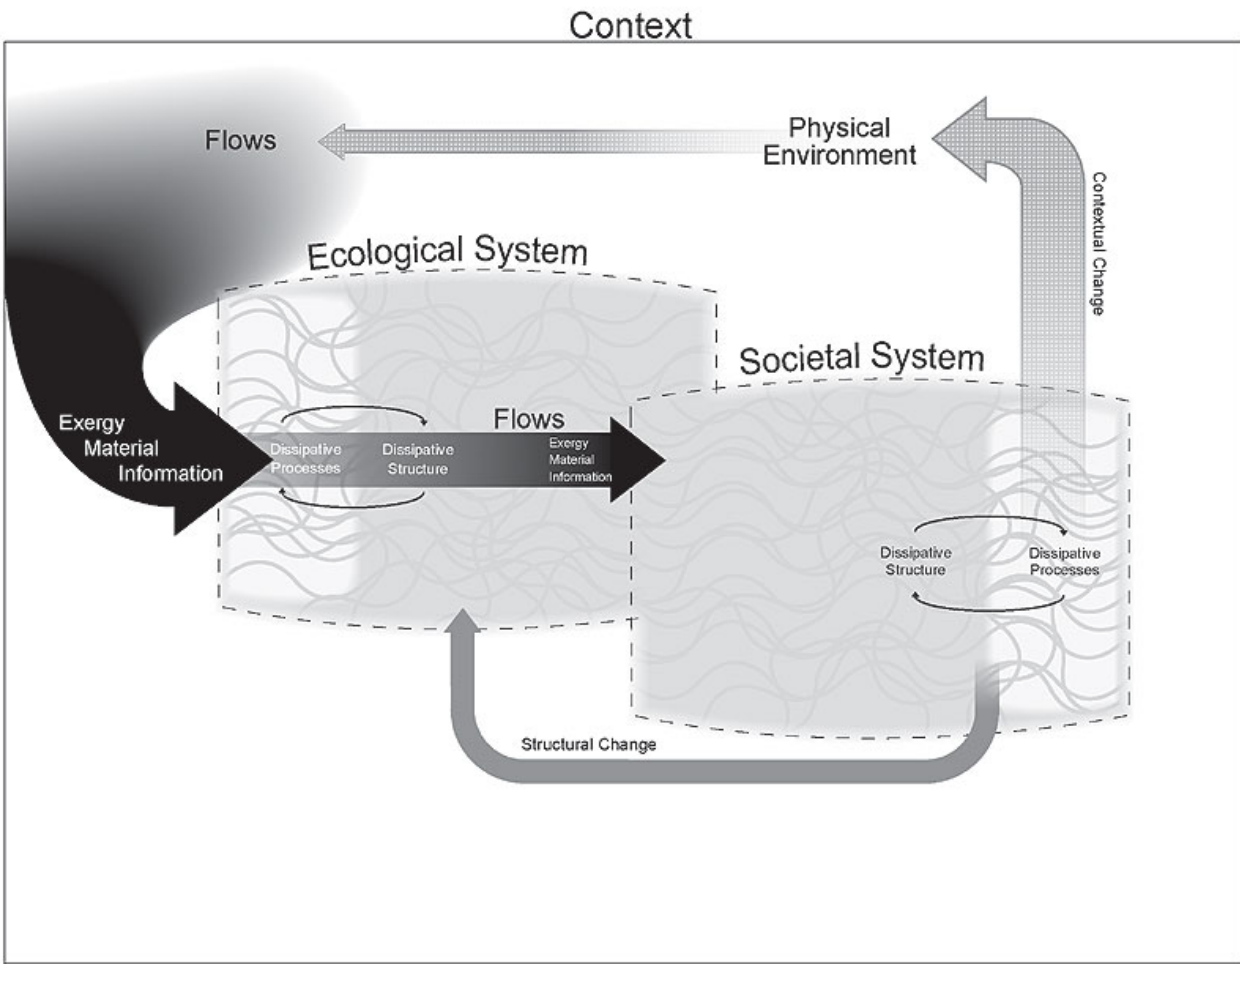
Figure 4 applies to one scale of